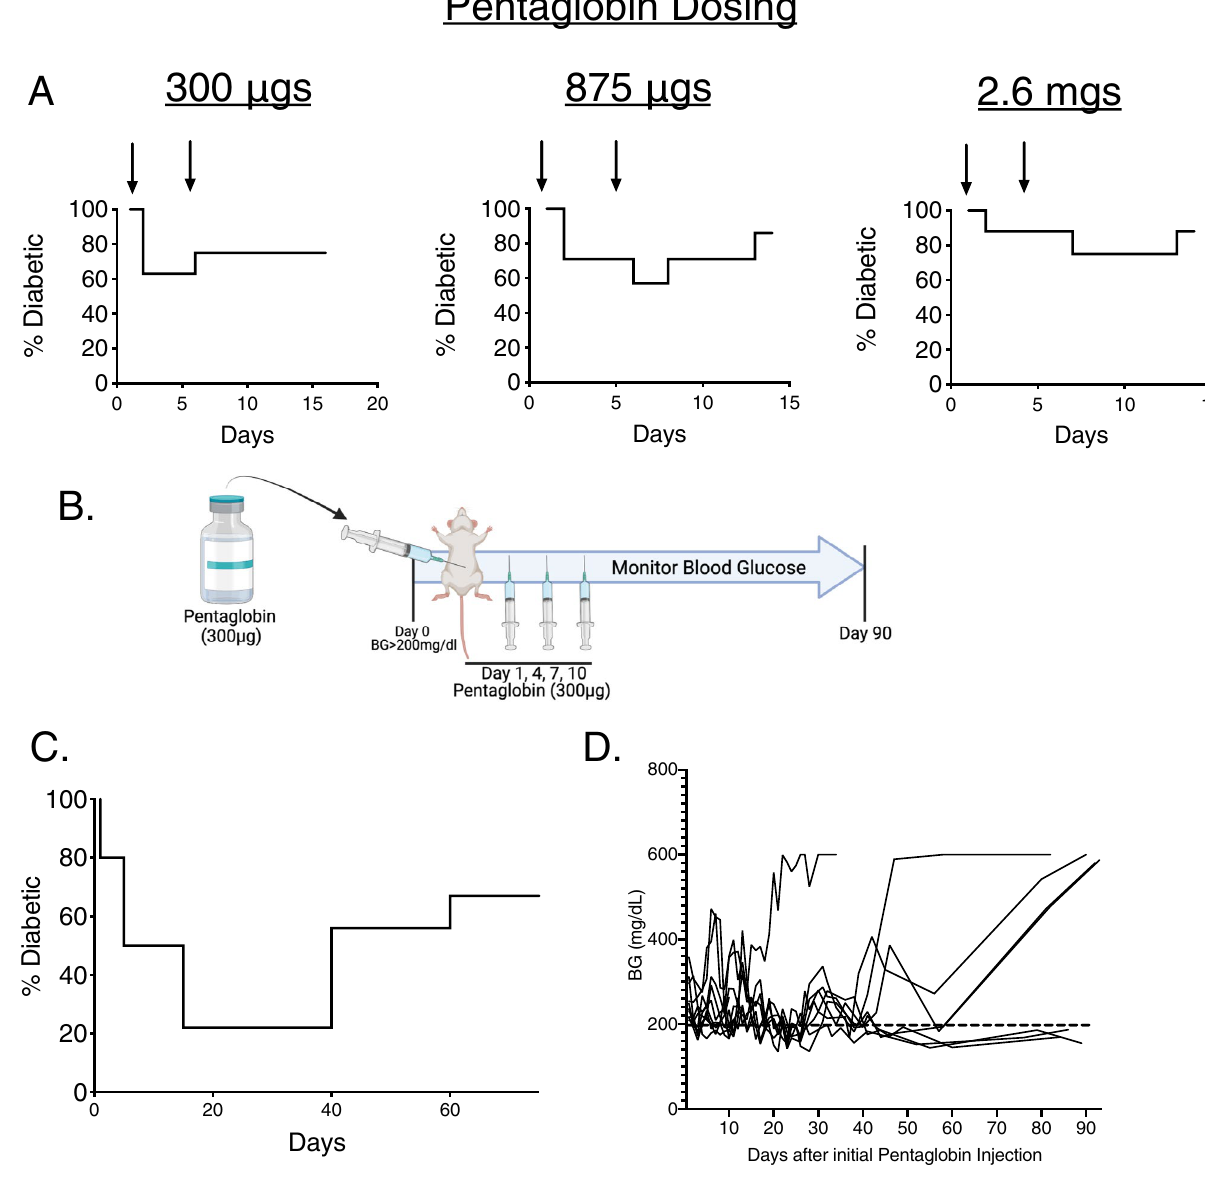
Figure 1. Pentaglobin reverses diabetes in NOD mice. ( A ) To determine the optimal therapeutic course for diabetes reversal by Pentaglobin, NOD mice were allowed to become diabetic as defined by two consecutive blood glucose readings between 200 and 300 mg/dL. These mice were then treated with 2 doses of 300 ug, 857 ug, or 2.6 mg of Pentaglobin on Day 1 and Day 4. ( n = 8) The 300ug dose provided maximum effectiveness in terms of overall reversal. ( B ) 4 doses of 300ug Pentaglobin were delivered 3 days apart in newly diabetic NOD mice to achieve better reversal. ( C ) Diabetic mice given 4 injections of Pentaglobin experienced ~ 78% reversal at day 15, with approximately 33% remaining diabetes free for 90 days. ( D ) Individual blood glucose readings in NOD mice taken during Pentaglobin treatment